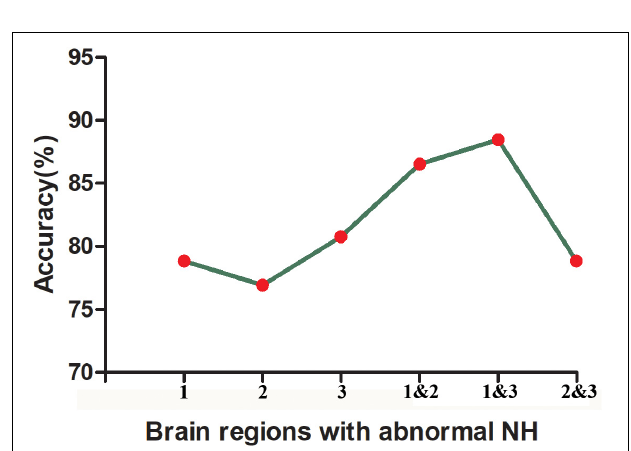
FIGURE 5 | The accuracy of using abnormal NH values of different brain regions to classify two patient groups. 1, right precuneus; 2, left middle temporal gyrus; 3, right middle temporal gyrus; 1&2, right precuneus and left middle temporal gyrus; 1&3, right precuneus and right middle temporal gyrus; 2&3, left middle temporal gyrus and right precuneus and right middle temporal